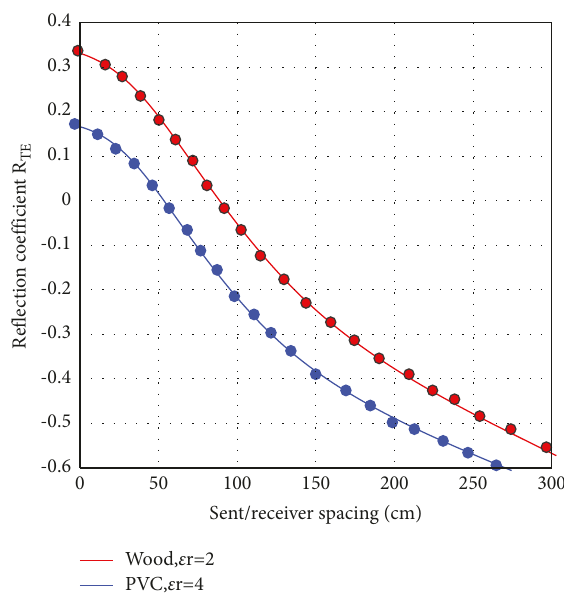
Figure 4: Reflection coefficient of electromechanical control signal in vertical polarization